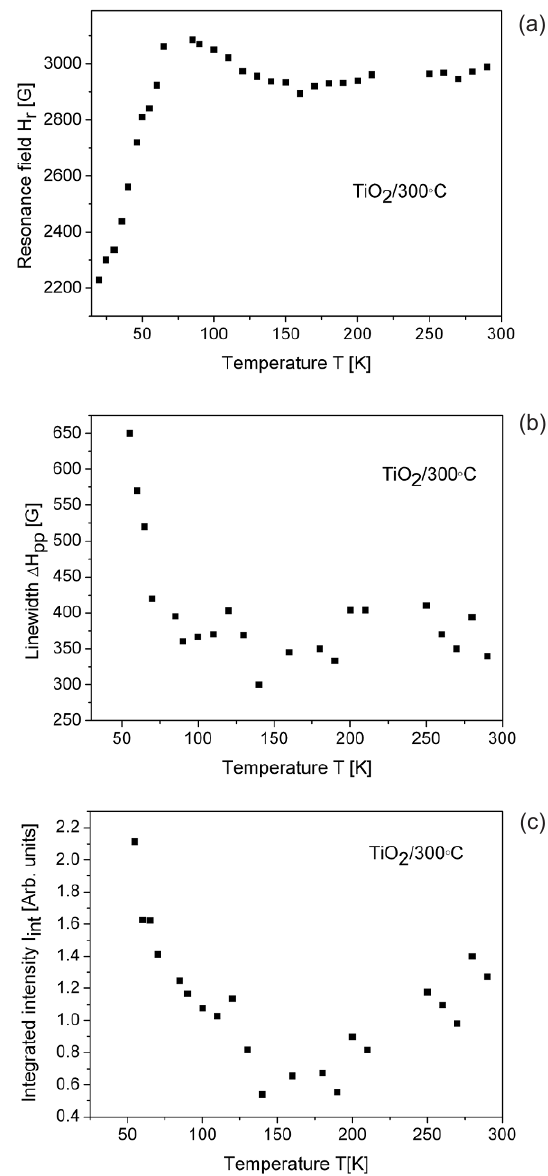
Figure 9. Temperature dependence of the resonance field H